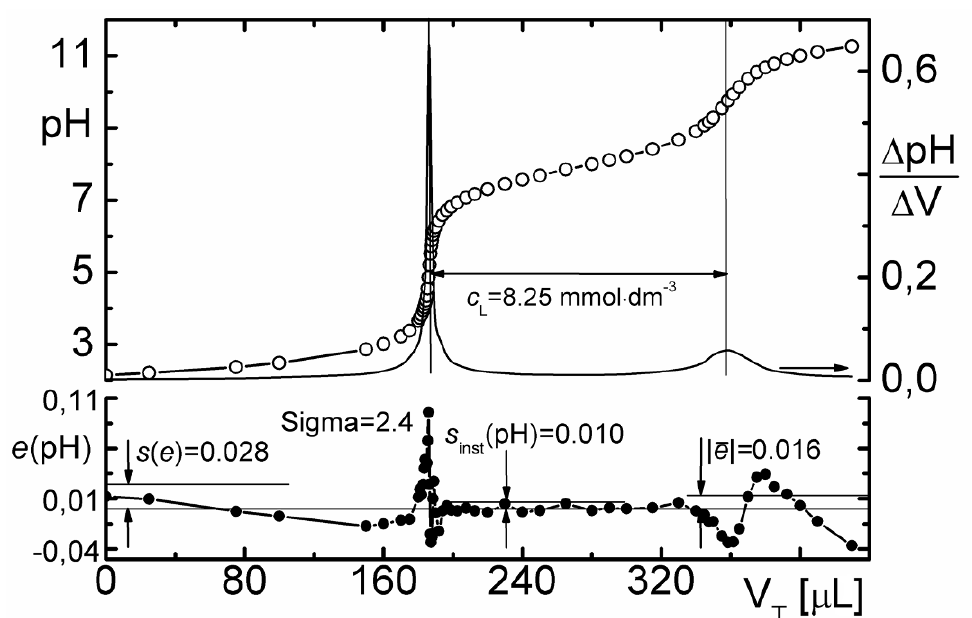
Figure 2. Determination of the analytical concentration of the vildagliptin c curve in original ( V , pH) co-ordinates (upper part) and the goodness-of-fit statistics s T regression search of the chemical model using HYPERQUAD (lower part). Experimental conditions : titrand c 0.876 mol dm -3 KOH, I = 0.03 (KCl), T = 298.16 K, s